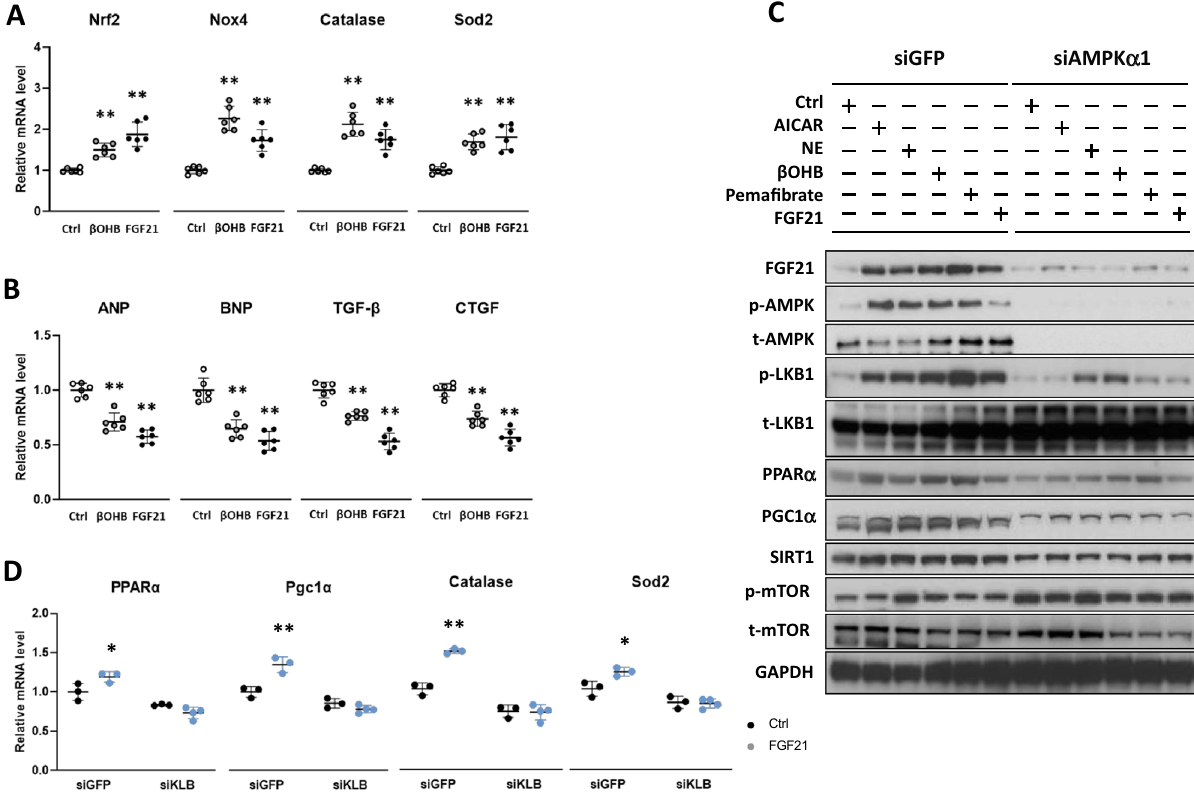
Figure 3. Effects of βOHB and FGF21 on the metabolism-related genes and proteins in the cultured cardiac myocytes. qPCR was performed to measure the expression levels for the oxidative response genes ( A ) or hypertrophic marker genes ( B ) after stimulation of the cells with βOHB (0.5 mM) and FGF21 (10 ng/mL). mRNA levels in stimulated cells were plotted relative to untreated control cells. Data are mean ± SD (n = 6). **p < 0.01 vs control analyzed by one-way ANOVA followed by Dunnett correction for multiple comparisons. ( C ) Representative western blots of indicated proteins. Neonatal rat ventricular cardiomyocytes